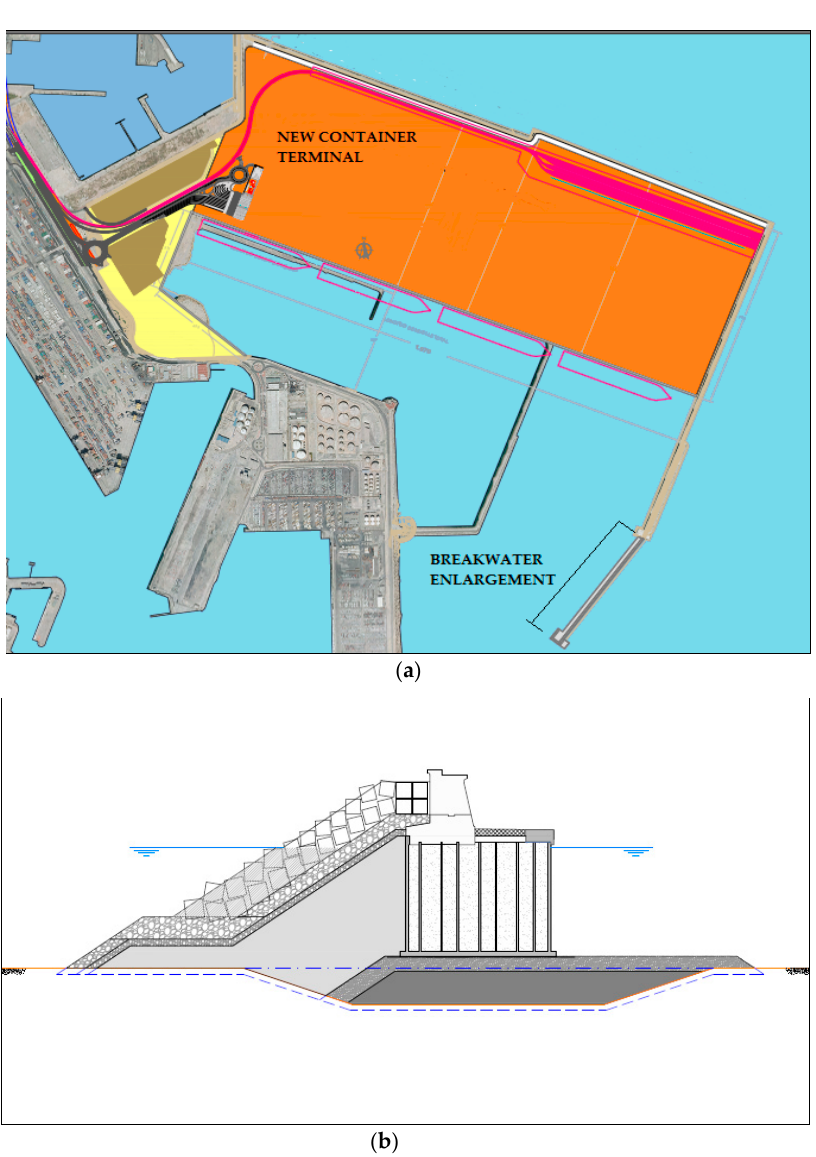
Figure 12. ( a ) Port of Valencia layout and ( b ) breakwater section. Source: Valencia Port Authority.